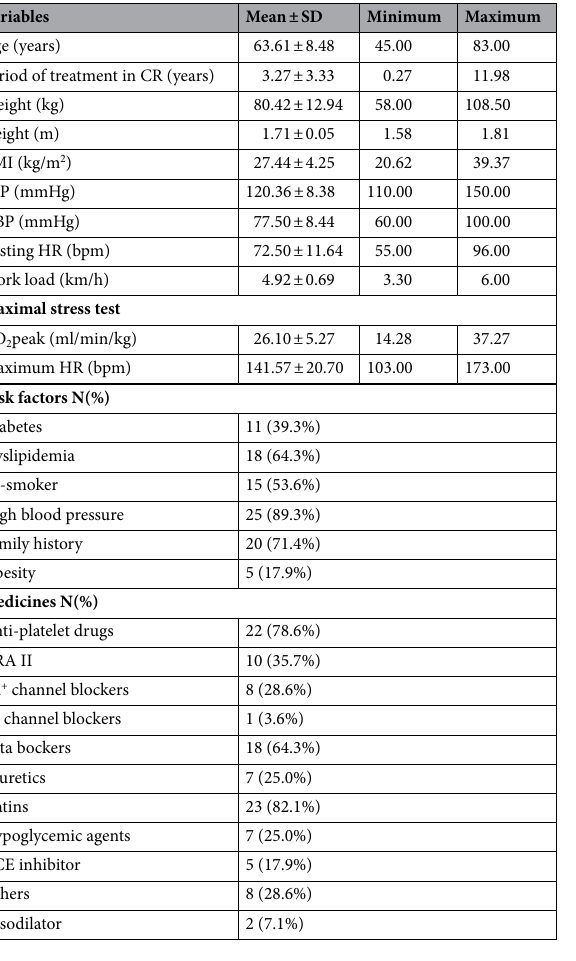
Table 1. Sample characterization (N = 28). CR cardiac rehabilitation, kg kilogram, m meters, kg/m 2 kilogram/